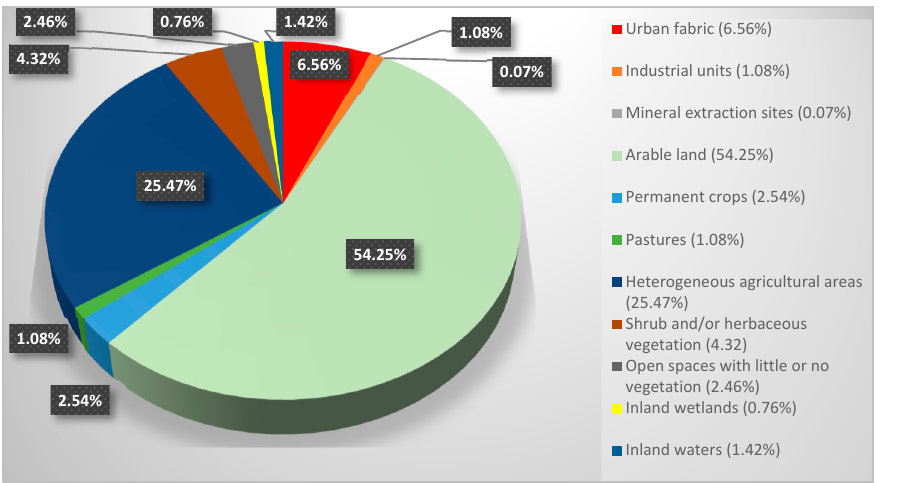
Figure 3. Land-uses distribution at the study area.